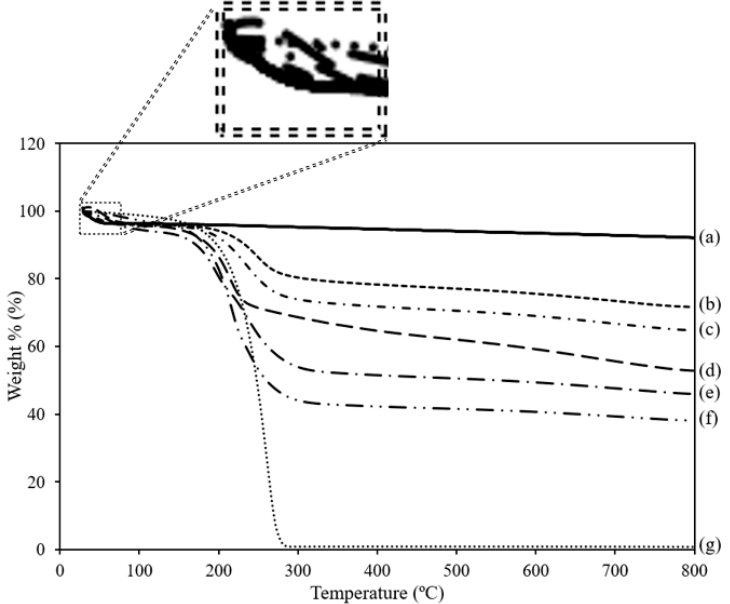
Figure 5. TGA profiles of ( a ) unfunctionalized MSU-2; MSU-2 functionalized with TEPA loadings of ( b ) 20 wt%, ( c ) 30 wt%, ( d ) 40 wt%, ( e ) 50 wt%, ( f ) 60 wt%; and ( g ) pure TEPA.